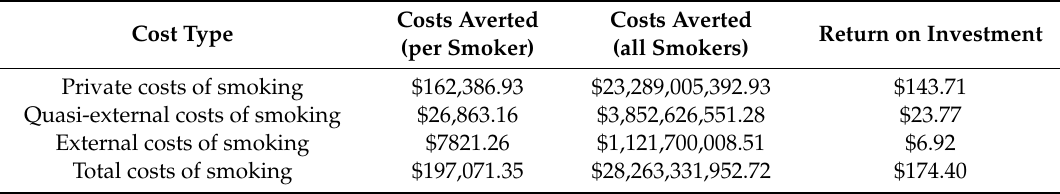
Table 3. Return on investment calculation for truth ®